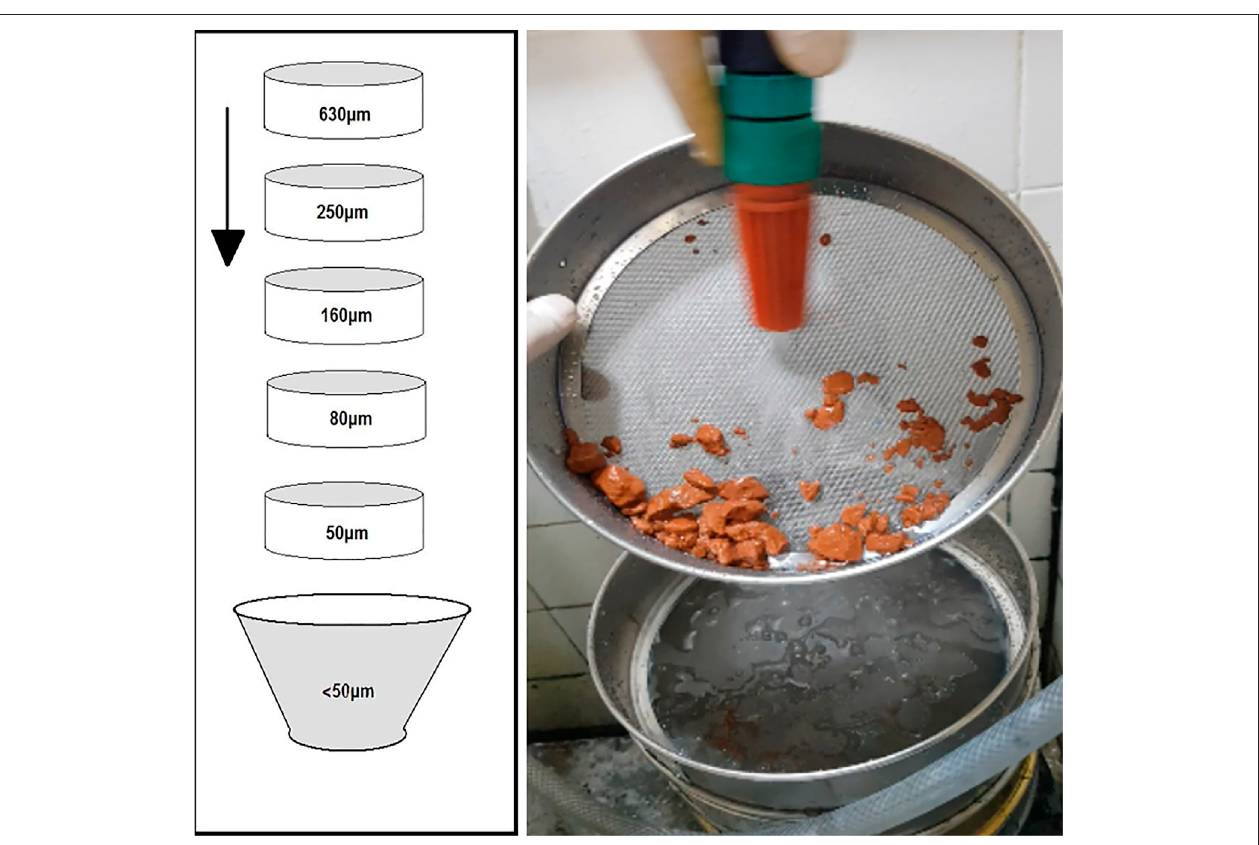
FIGURE 5 | Battery of sieves (630, 250, 160, 80, and 50 µm) and fi nal recipient to store sediments smaller than 50 µm.